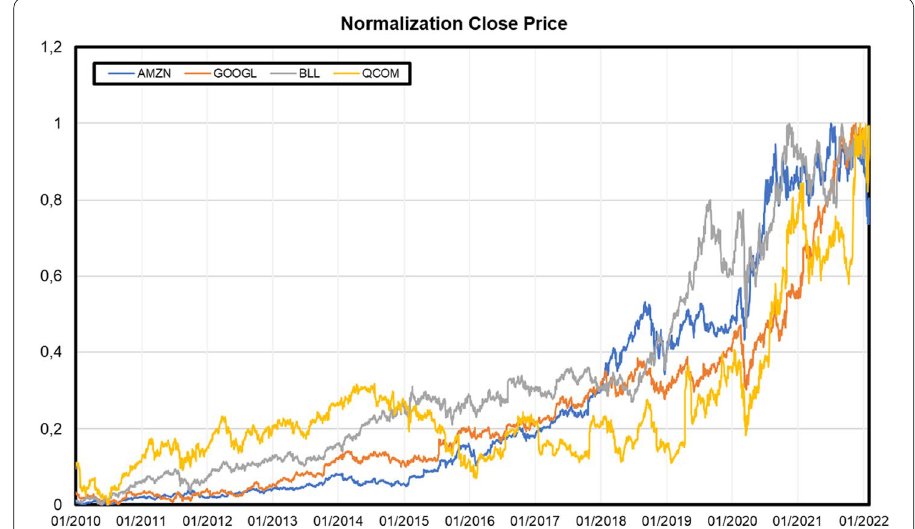
Fig. 9 Visualization of the normalize close price time-series data of the selected four companies